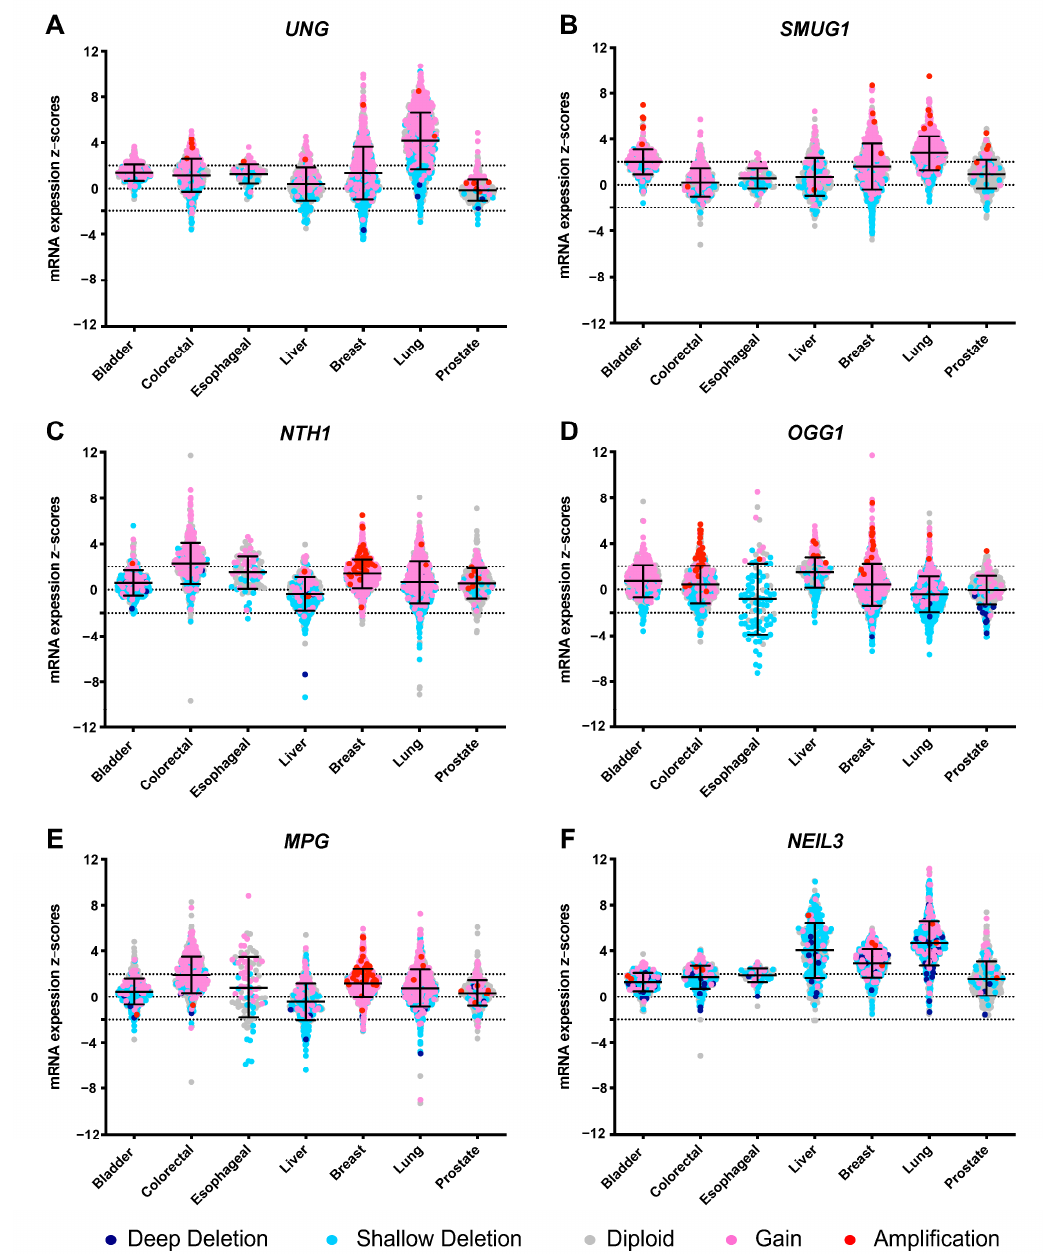
Figure 2. mRNA expression profiles of six representative DNA glycosylase genes in various carcinomas. mRNA expression profiles of UNG ( A ), SMUG1 ( B ), NTH1 ( C ), OGG1 ( D ), MPG ( E ) and NEIL3 ( F ). Data were extracted from the cBio Cancer Genomics Portal [140] by computing the expression of an individual gene in a tumor sample (z-score) relative to the gene’s expression in the normal sample. Samples with expression z-scores > 2 or < − 2 (indicated with dotted lines) in any queried gene are considered altered. mRNA expression levels are organized according to the copy-number level per gene: Deep deletion (dark blue) indicates a deep loss, possibly a homozygous deletion; shallow deletion (sky blue) indicates a shallow loss, possibly a heterozygous deletion; diploid (gray); gain (pink) indicates a low-level gain (a few additional copies, often broad); and amplification (red) indicates a high-level amplification (more copies, often focal). Cancer types: Bladder urothelial carcinoma (bladder; N = 404), colorectal adenocarcinoma (colorectal; N = 590), esophageal squamous cell carcinoma (esophageal; N = 94), hepatocellular carcinoma (liver; N = 358), invasive breast carcinoma (breast; N = 1068), non-small cell lung cancer (lung; N = 991), and prostate adenocarcinoma (prostate; N =